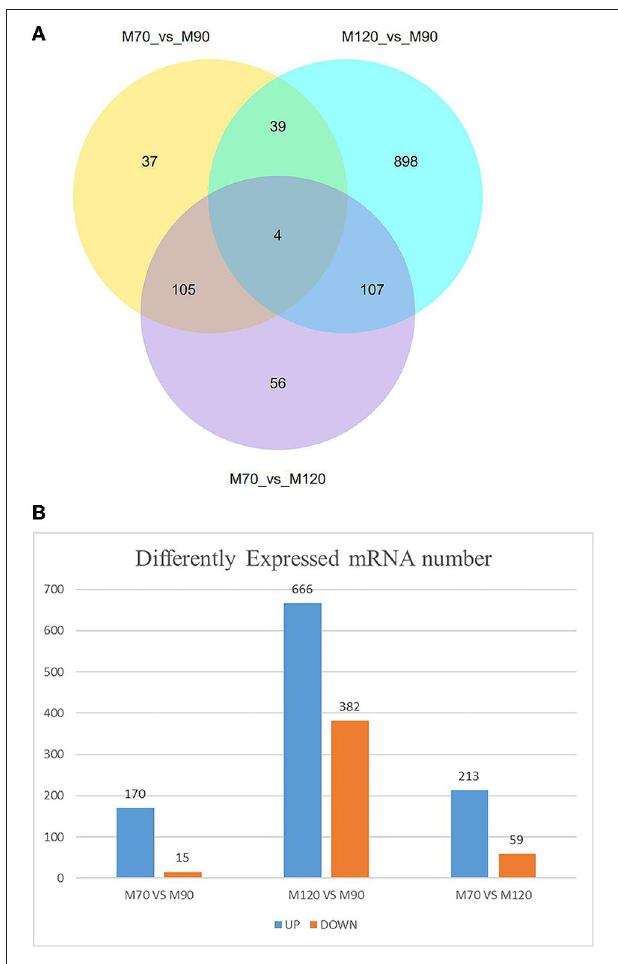
FIGURE 1 | Number of DEGs at different time stage comparisons. (A) The venn diagram shows the number of DEGs across three comparisons: M70 VS M90, M120 VS M90, M70 VS M120. (B) The number of up- and downregulated DEGs across three comparisons: M70 VS M90, M120 VS M90, M70 VS M120, with the threshold set to q < 0.05.